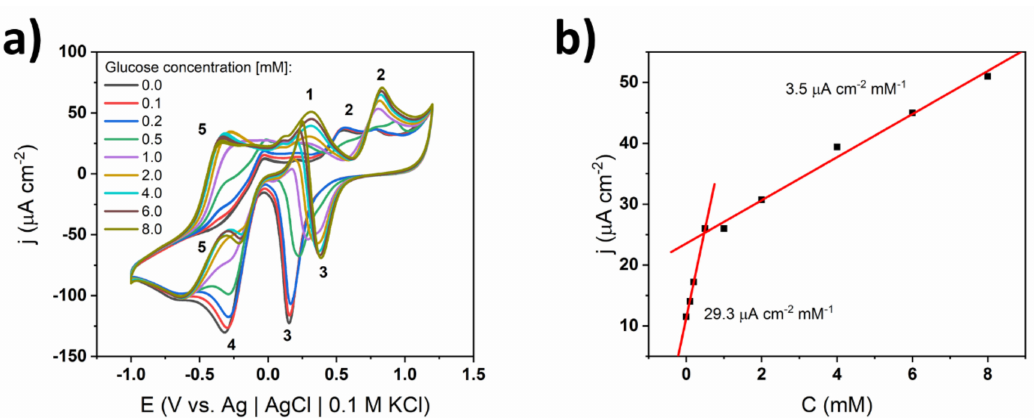
Figure 3. ( a ) Cyclic voltammograms of TiND | AuNP uncoated electrode registered for di ff erent glucose concentrations in 0.1 X commercial phosphate bu ff er PBS (cPBS), ( b ) calibration curve based on glucose oxidation peak at + 0.35